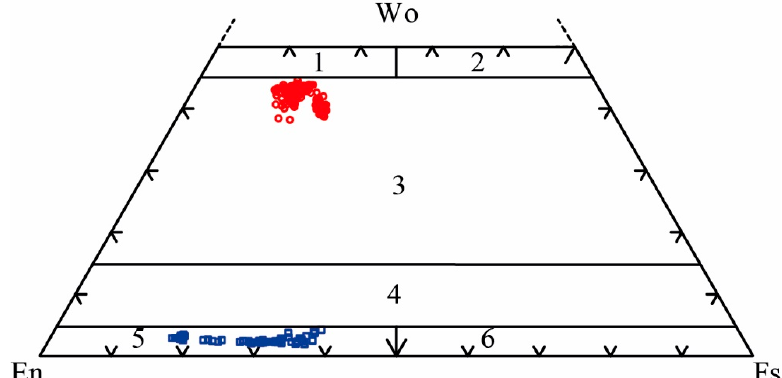
Figure 6. Pyroxene composition of the dacite flows of the TSESDAI eruptive complex in the enstatite (En), Wollastonite (Wo), and ferrosilite (Fs) triangle of [43]. Blue circles indicate the analyzed orthopyroxenes. Red circles indicate the analyzed clinopyroxenes. The numbers (1 to 6) indicate respectively; Diopside, Hedenbergite, Augite, Pigeonite, Clinoenstatite, Clinoferrosilite.